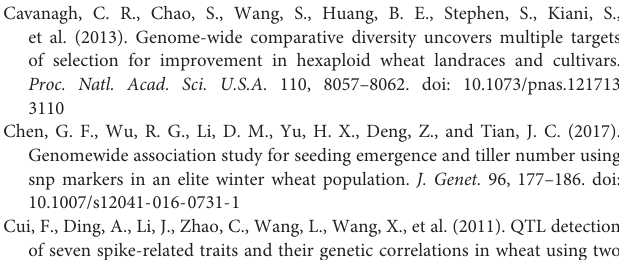
TABLE S1 | The detail information of each bin in linkage map construction. TABLE S2 | QTL detected by multi-environmental